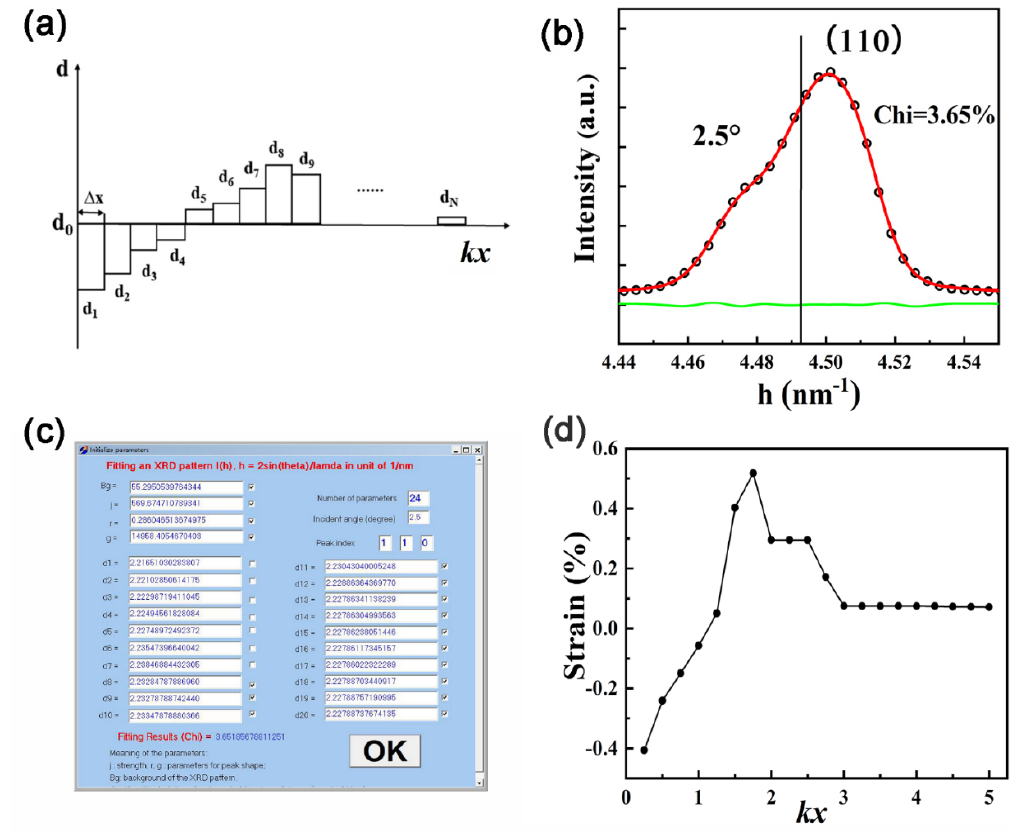
Figure 3. ( a ) Schematic distribution of interplaner spacing. ( b ) The fitting result of (110) peak at an incident angle of 2.5°. ( c ) Fitting parameters in the program at an incident angle of 2.5°. ( d ) The strain-depth ( kx ) profile obtained from the fitting.